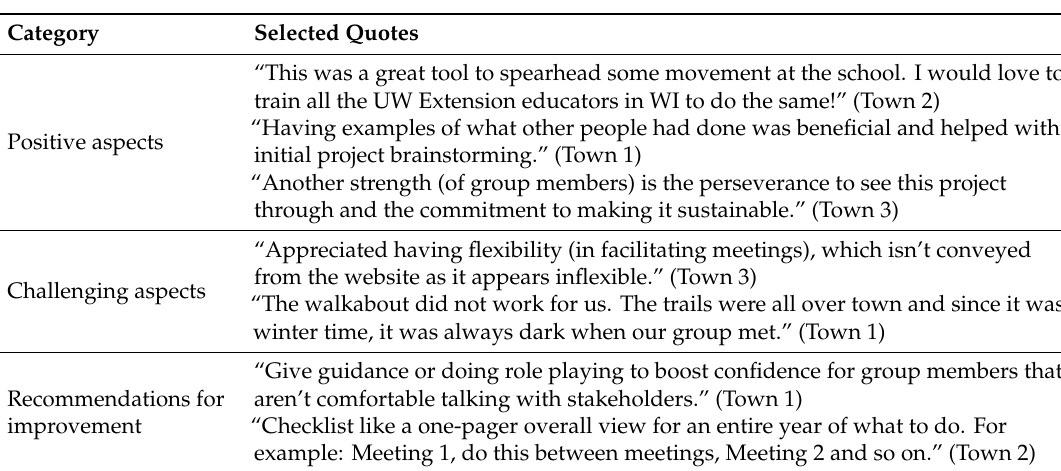
Table 5. Qualitative feedback from eHEART